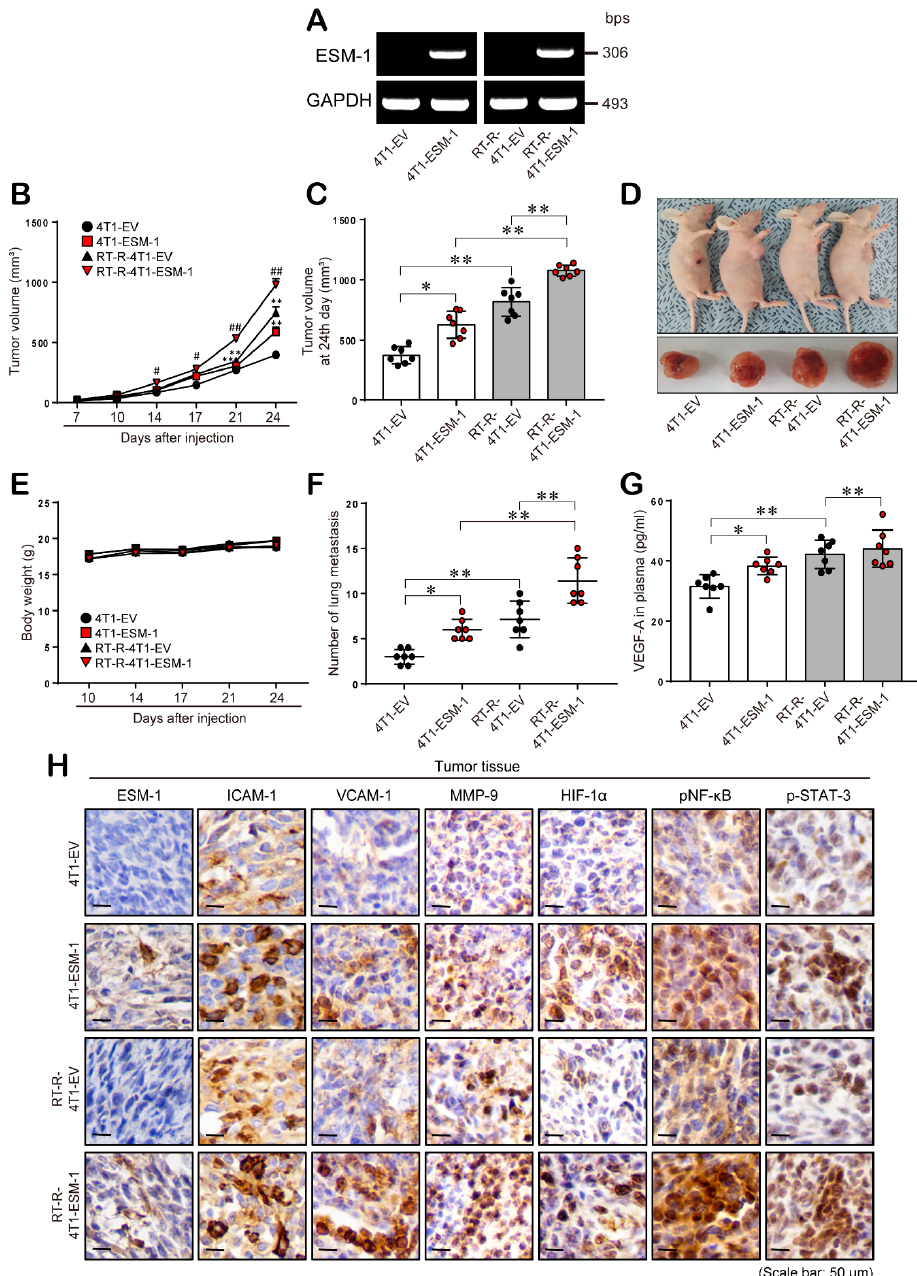
Figure 6. ESM-1 overexpression increases tumor growth and metastasis in an in vivo mouse model. ( A ) 4T1 and RT-R-4T1 mouse breast cancer (BC) cells were stably transfected with expression plasmid vectors encoding ESM-1 (4T1-ESM-1 and RT-R-4T1-ESM-1 cells) or with an empty vector (4T1-EV and RT-R-4T1-EV cells) as described in the methods section. The full blot image can be found in Figure S6. ( B – H ) Athymic nude mice were divided into four groups and injected subcutaneously with 4T1-EV cells (4T1; n = 7), RT-R-4T1-EV cells ( n = 7), 4T1-ESM-1 cells ( n = 7), or RT-R-4T1-ESM-1 cells ( n = 7) (5 × 10 4 cells / 50 µ L of serum-free medium). The mice were sacrificed on the 24th day, and the tumors and lung tissues were extracted. Tumor volume ( B – D ) and body weight ( E ) were measured every three days during tumor development. The incidence of lung metastasis ( F ) was examined after sacrifice. ( G ) VEGF-A was detected in the plasma by ELISA. The data represent the mean ± SD. * p < 0.05, ** p < 0.01. ( H ) Tumor tissue sections were stained with anti-ESM-1, ICAM-1, VCAM-1, MMP-9, HIF-1 α , phospho-NF- κ B, and phospho-STAT-3